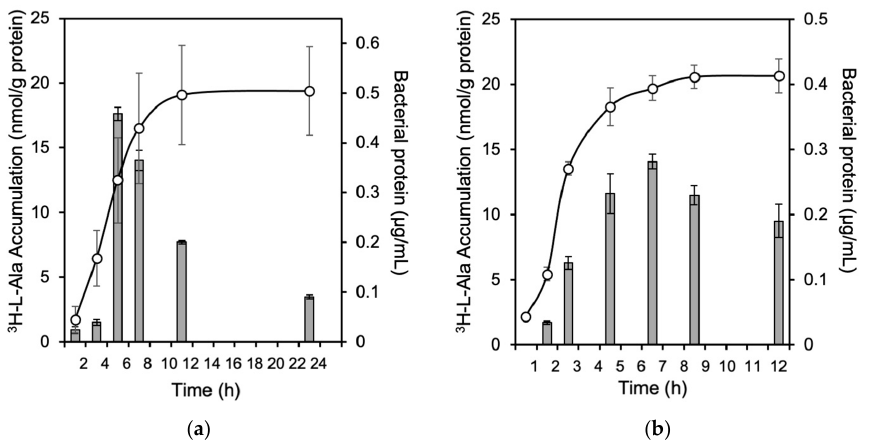
Figure 3. Accumulation of 3 H-L-Ala in ( a ) E. coli K-12 and ( b ) EC-14 at each growth stage. H-L-Ala accumulation in K-12 showed the highest uptake during the log phase, but not much uptake during the stationary phase. In contrast, the accumulation by EC-14 remained high from the logarithmic growth stage to the stationary phase.